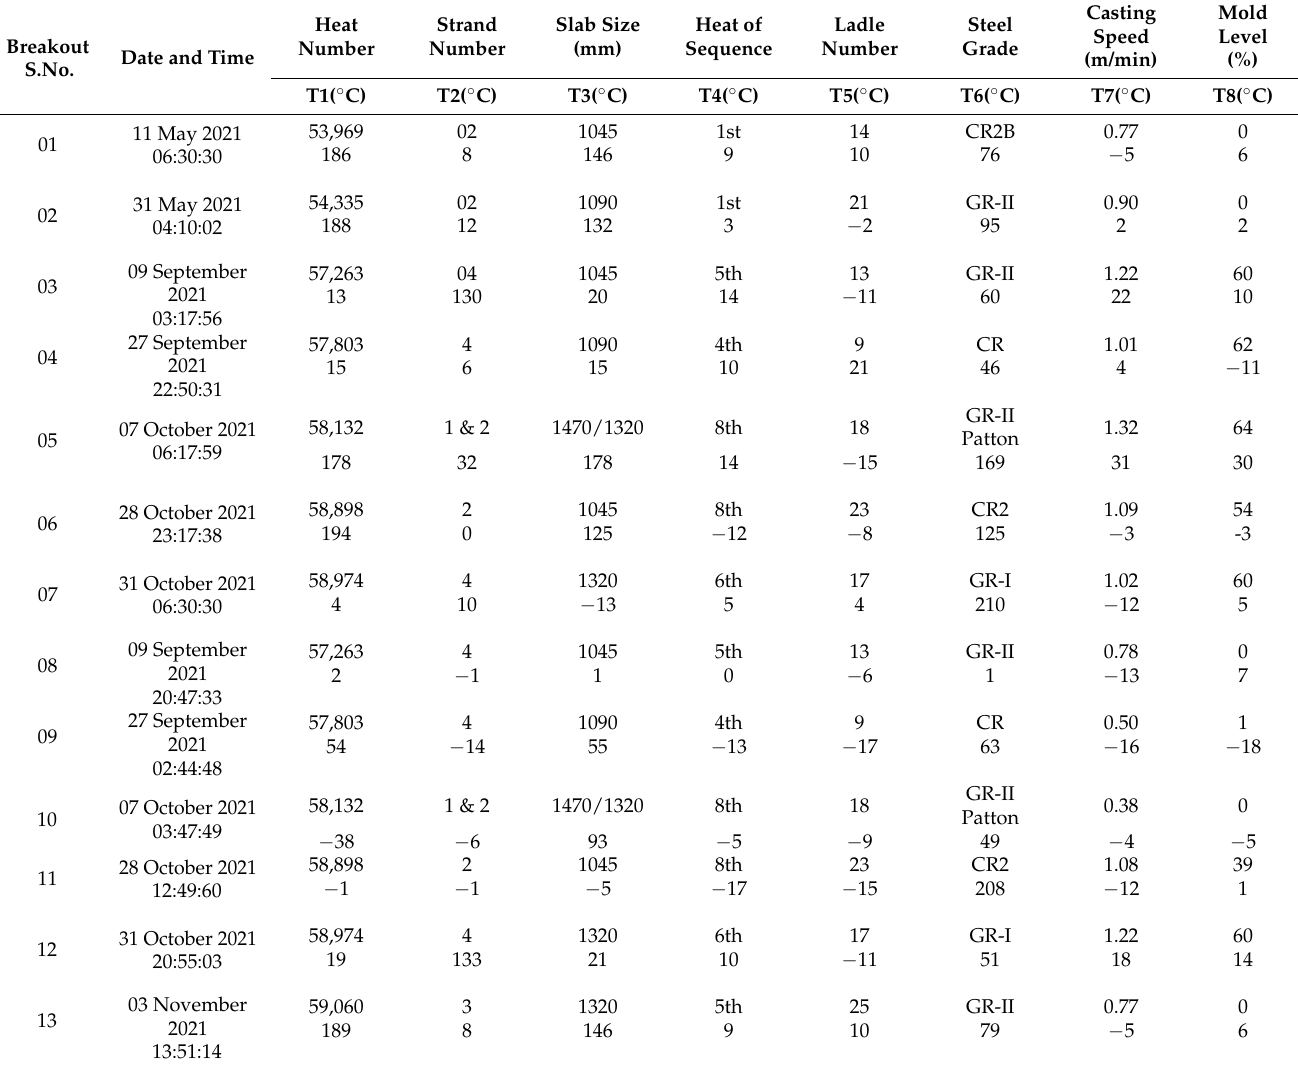
Table 3. Breakout in continuous casting shop (CCS) from 1 April 2021 to 31 September